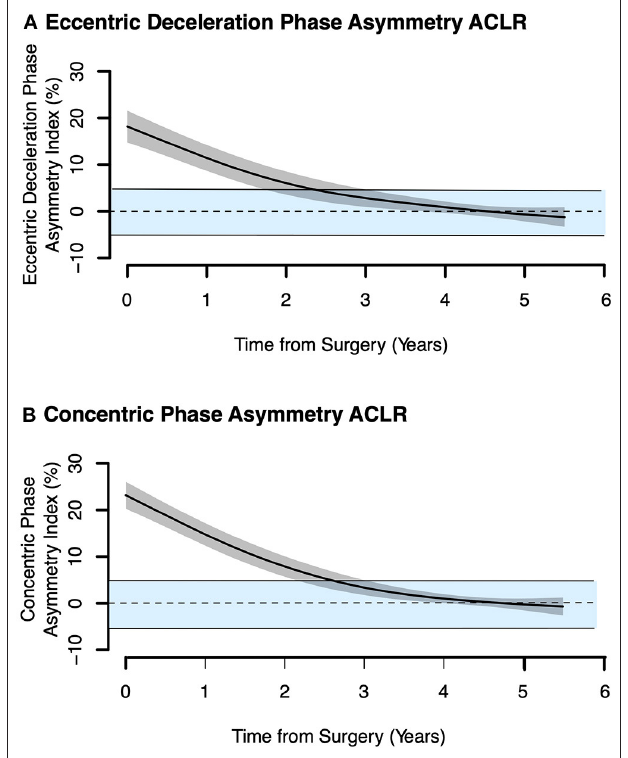
FIGURE 5 | Between-limb asymmetry index for the the anterior cruciate ligament reconstructed (ACLR) group vs. time from surgery. Solid horizontal lines show ± 1 SD for non-injured controls, and 0% reference line (shaded blue region). Model output shows the mean value for the typical athlete ± the